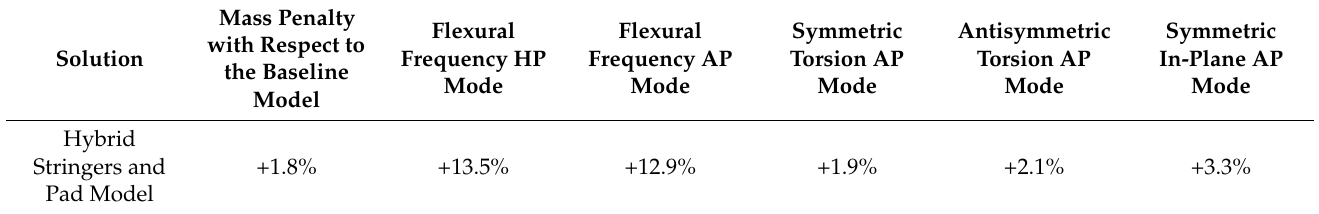
Table 2. Wing Dynamic Status: Solution with Hybrid Stringers and Pads—modes in the helicopter and aircraft mode.